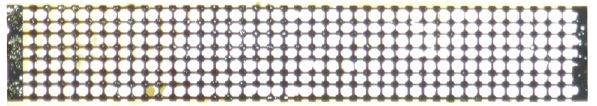
Fig. 3 Sample of homogenous flow pattern saturated with crude oil (dark color is oil; white color is grain)